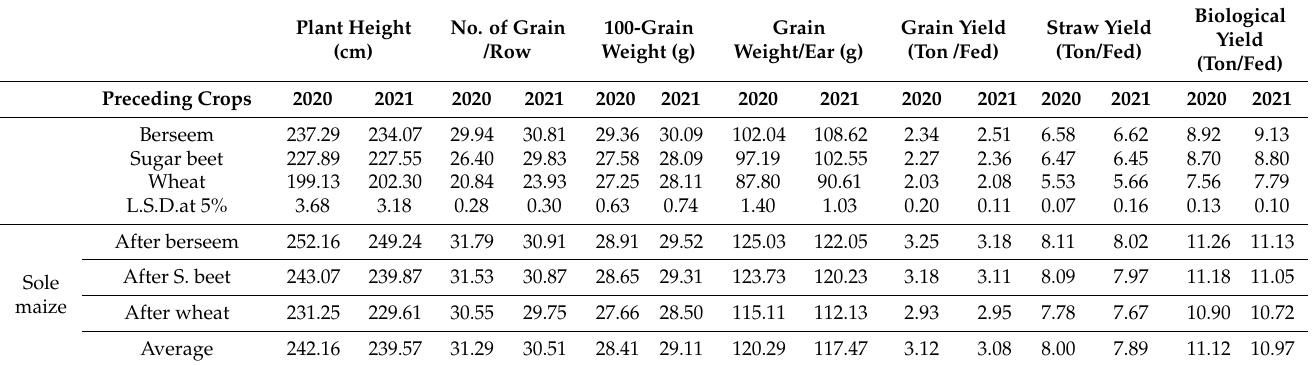
Table 4. The effect of preceding crops on maize yield and some of its components under intercropping system compared with sole maize during 2020 and 2021 seasons.